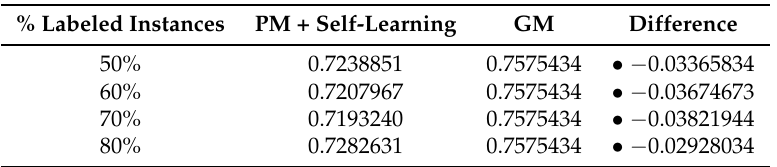
Table 10. D5: Opportunity dataset accuracies for varying % of labeled instances with self-learning (PM + self-learning) and the General Model